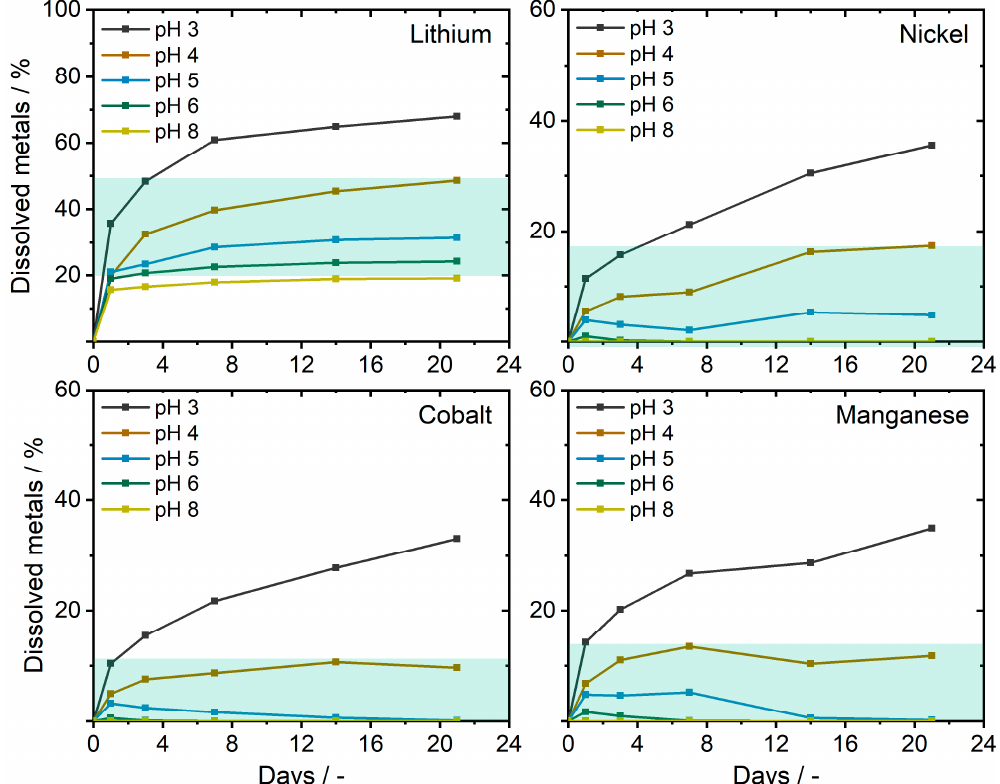
Figure 2. Lithium-ion batteries (LIB) metal dissolution from the ash of deactivated pouch cells (NCM111 positive electrode material) in aqueous media at different pH values. Values observed at an acceptable soil pH range for plants are indicated in green (pH 3–8).